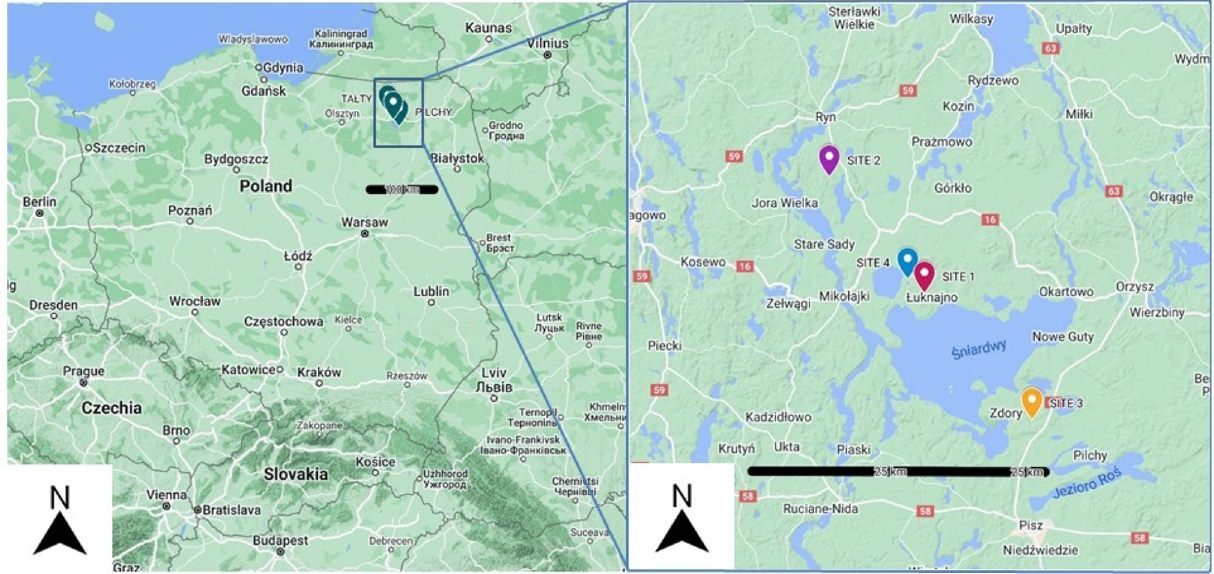
Figure 1. Map showing study sites located in north-eastern Poland. Study sites are located within Mazury Lake District. Site 1—Urwitałt forest; Site 2—Tałty forest, Site 3—Pilchy forest; Site 4—Urwitałt open grasslands. Black bars indicates the distance. (Map data, Google Maps 2022. https:// maps. google.